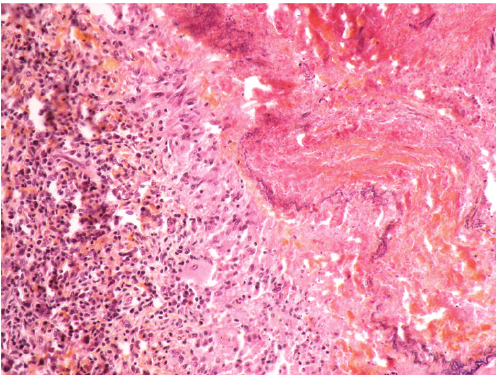
Figure 2: At histological examination, the pulmonary nodule was centered by an area of necrosis, surrounded by a palissade of histiocytes, sometimes giant and multinucleated. Elastic stain enlightens the elastic lamnia, partially destroyed by this granulo- matous inflammation (Elastic Stain, original magnification ×